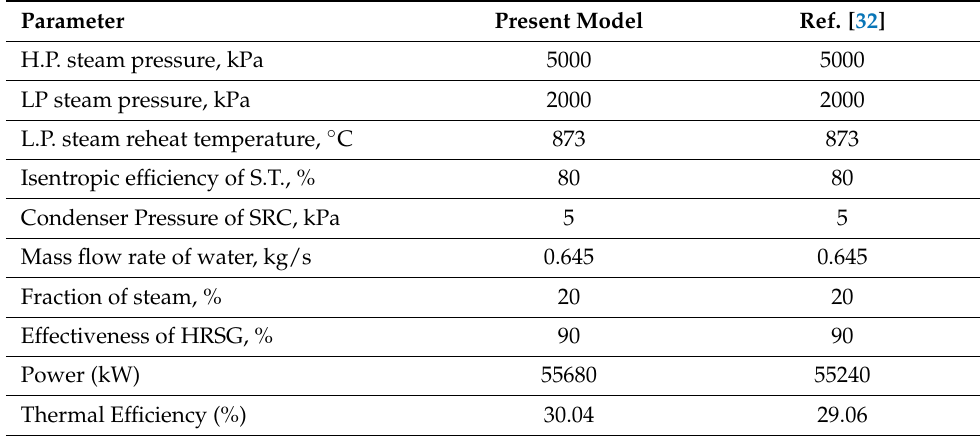
Table 6. Validation of regenerative Rankine cycle model.